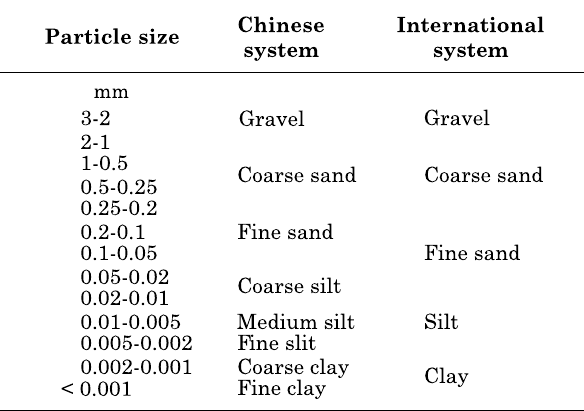
Table 1. Comparison of Chinese taxonomy and international system for particle